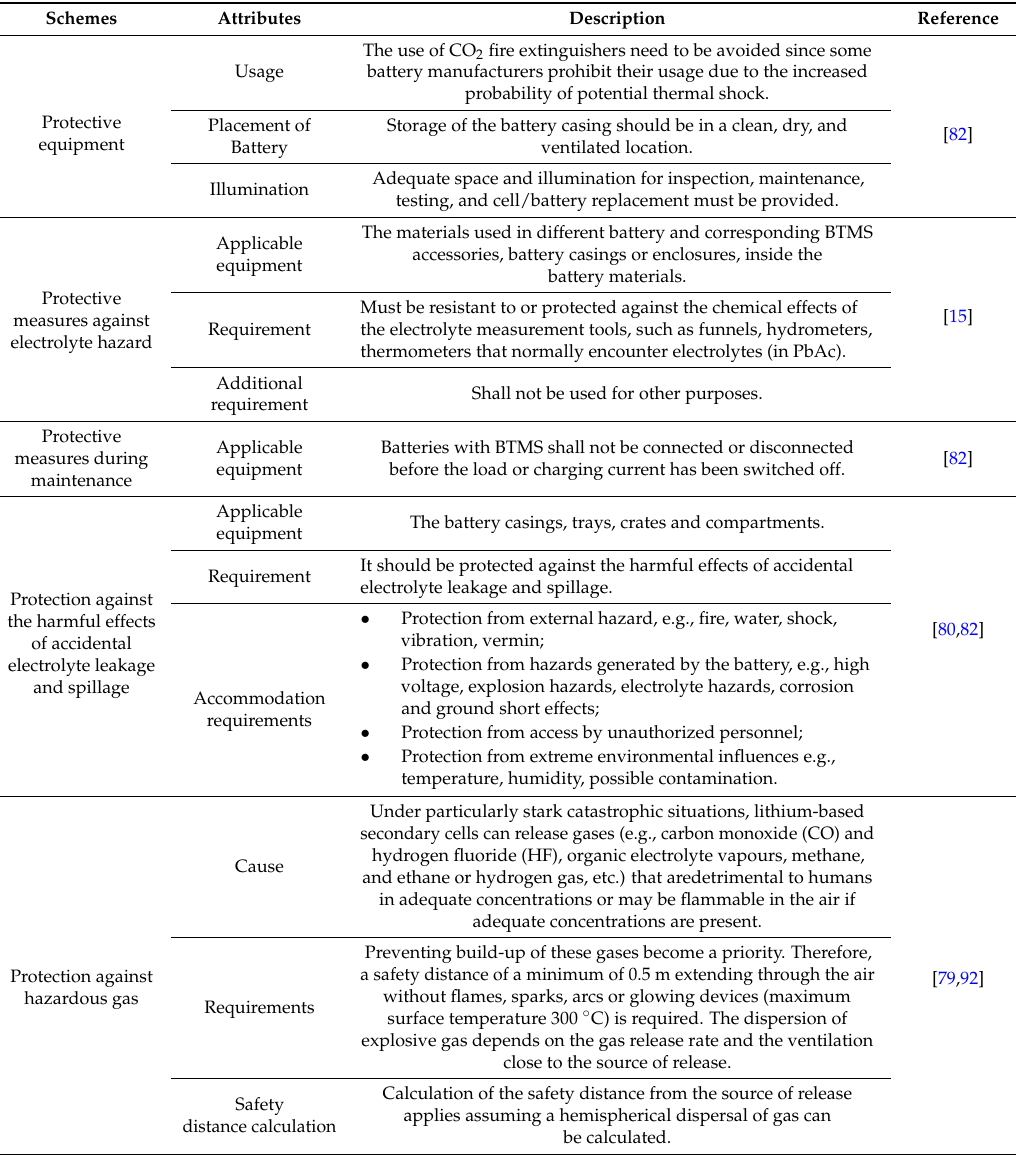
Table 4. BTMS protection